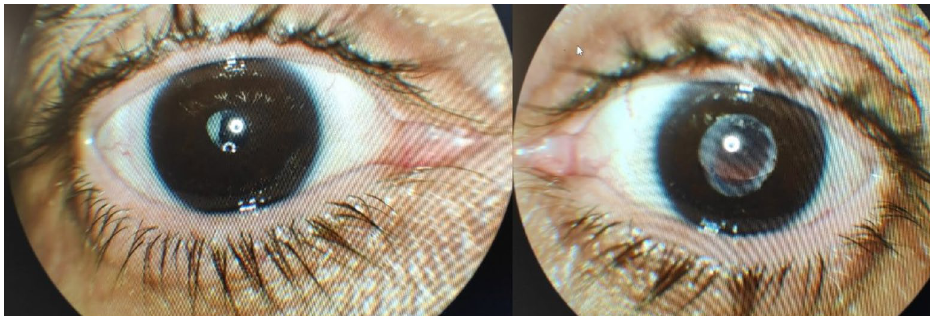
Fig. 3 Signs of bilateral cataract surgery and intraocular